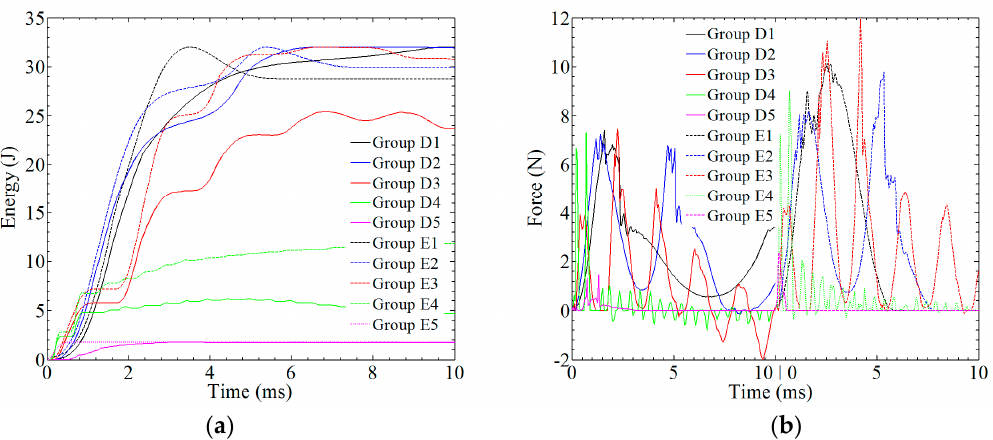
Figure 17. The analysis of the impact resistance of the composite laminate in group D and group E: ( a ) absorbed energy; ( b ) contact force.